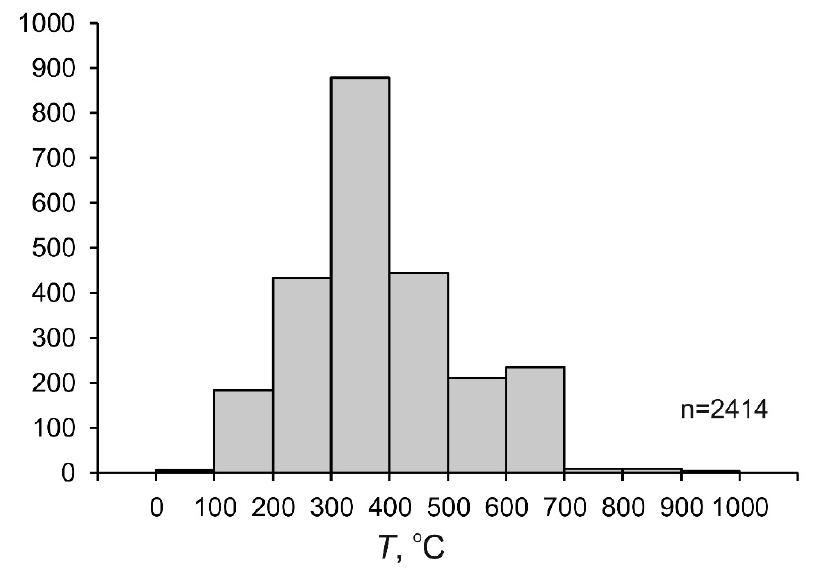
Figure 4. Histogram of the temperature of mineralizing fluids at porphyry deposits.